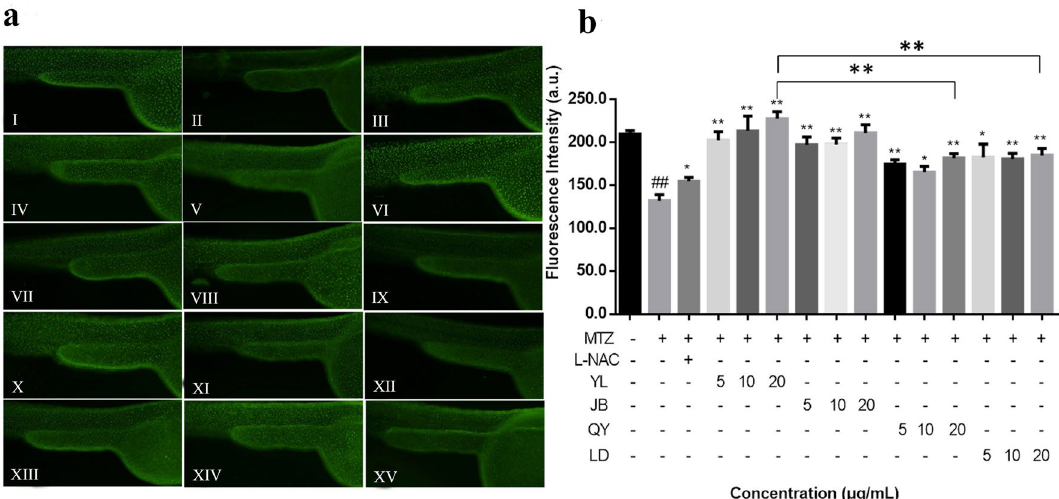
Figure 7. Thyme oils inhibited MTZ-induced oxidative insults in skin cells of Tg (krt4: NTR-hKikGR) cy17 transgenic zebrafish ( a ): Control group (I); MTZ-treatment group (II); MTZ + L-NAC-treatment gruop (III); MTZ + YL-thyme oil-treatment group at the concentration of 5 μg/mL (IV), 10 μg/mL (V) and 20 μg/mL (VI); MTZ + JB-thyme oil-treatment group at the concentration of 5 μg/mL (VII), 10 μg/mL (VIII) and 20 μg/mL (IX); MTZ + QY-thyme oil-treatment group at the concentration of 5 μg/mL (X), 10 μg/mL (XI) and 20 μg/mL (XII); MTZ + LD-thyme oil-treatment group at the concentration of 5 μg/mL (XIII), 10 μg/mL (XIV) and 20 μg/ mL (XV); Determination of fluorescence intensity by Image analysis (b); The values are expressed as mean ± SD ( n = 15). * Represents p -value less than 0.05 and ** represents p -value less than 0.01 vs. MTZ group; # represents p value less than 0.05 and ## represents p value less than 0.01 vs. control